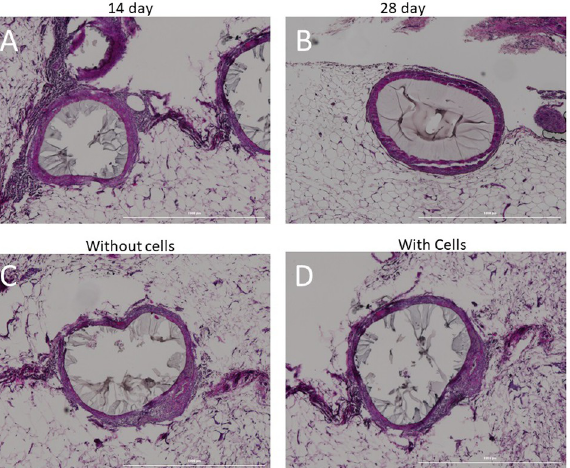
Fig 6. Histology of transplant sites in healthy dogs. A) Example of the mild peri-microspheres fibrosis with inflammatory cells in the surrounding tissue was noted in healthy dogs at 14 days. B) By 28 days the inflammatory response had decreased and was pathologically described as mild. C) Example of foreign body response surrounding microsphere without cells. D) Example of response to microsphere containing allogeneic canine islets. All scale bars = 1000 μ m.